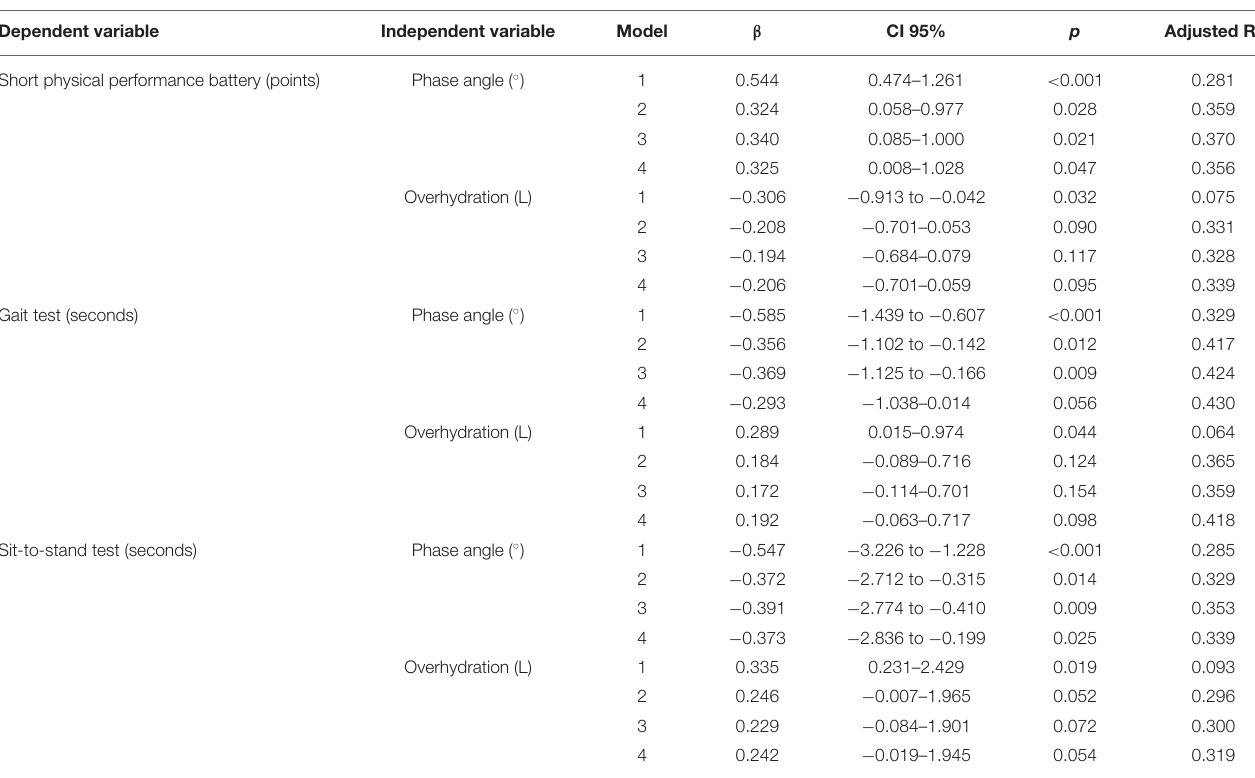
TABLE 5 | Multiple linear regression models with short physical performance battery, the gait test, and the sit-to-stand test as dependent variables in patients on peritoneal dialysis ( n = 49). Dependent